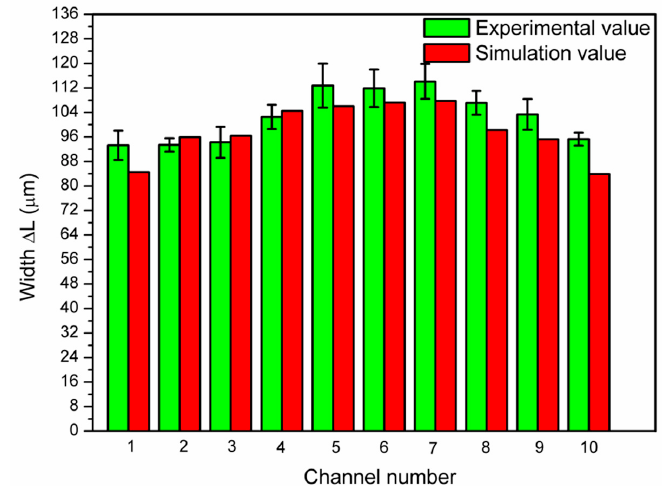
Figure 18. The width ∆ L of the flat bottom region of each channel in the same section under the laser energy of 1800 mJ.